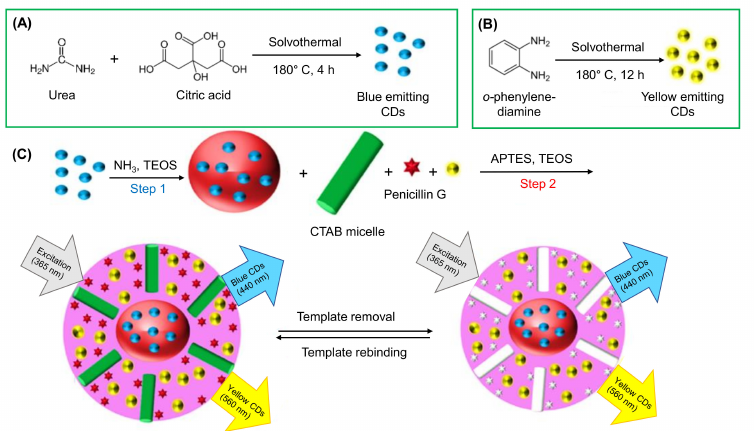
Figure 17. ( A ) Synthesis of blue emitting CDs. ( B ) Synthesis of yellow emitting CDs. ( C ) Schematic representation of a blue and yellow emitting CDs-based fluorescence MIP sensor for penicillin G detection. Reproduced from [258], with permission from Elsevier, 2020. TEOS: tetraethoxysilane; APTES: 3-aminopropyltriethoxysilane; CTAB: cetyltrimethylammonium